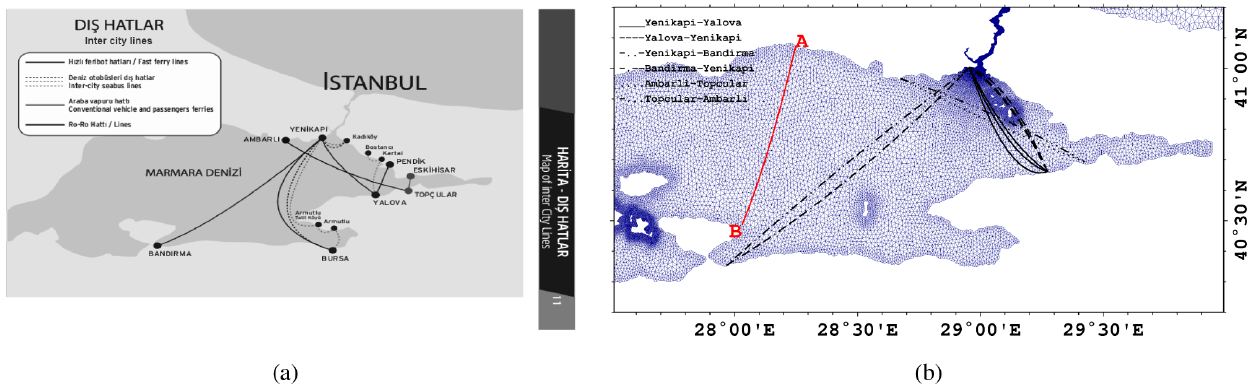
Figure 5. (a) The routes of the intercity ferry lines from Istanbul and to Istanbul suggested by the operating company IDO (http://www.ido. com.tr, last access: June 2018). (b) Approximate unidirectional ferry tracks. The legend shows the direction of the ferries. The section A–B is used only for impact assessment against the NR. Triangular mesh of the model is underlaid.